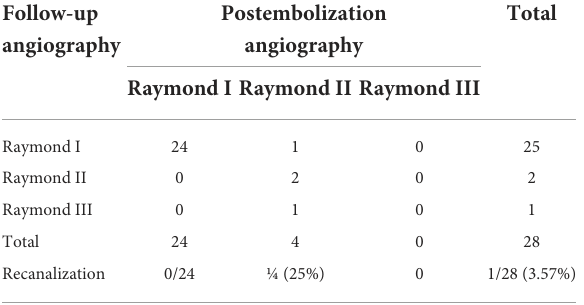
TABLE 3 Follow-up angiographic